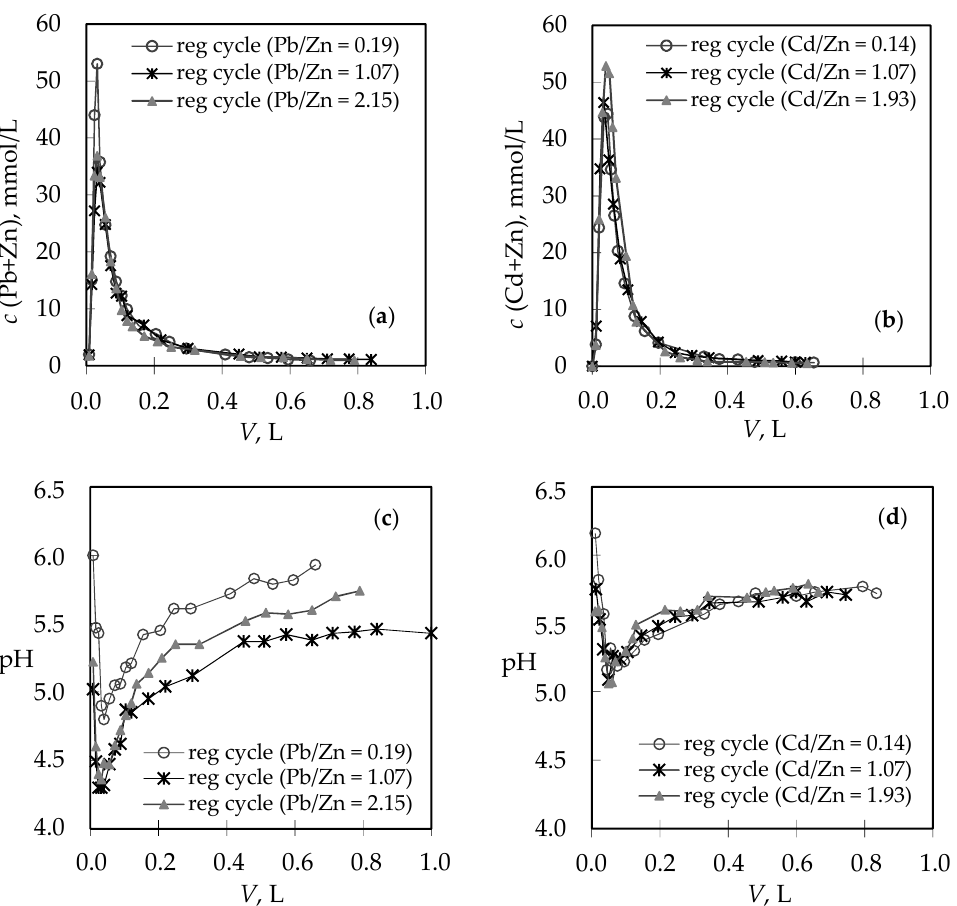
Figure 6. Regeneration curves for different Pb/Zn and Cd/Zn concentration ratios expressed as: ( a , b ) Effluent concentrations versus volume; ( c , d ) pH changes during regeneration cycles versus volume.